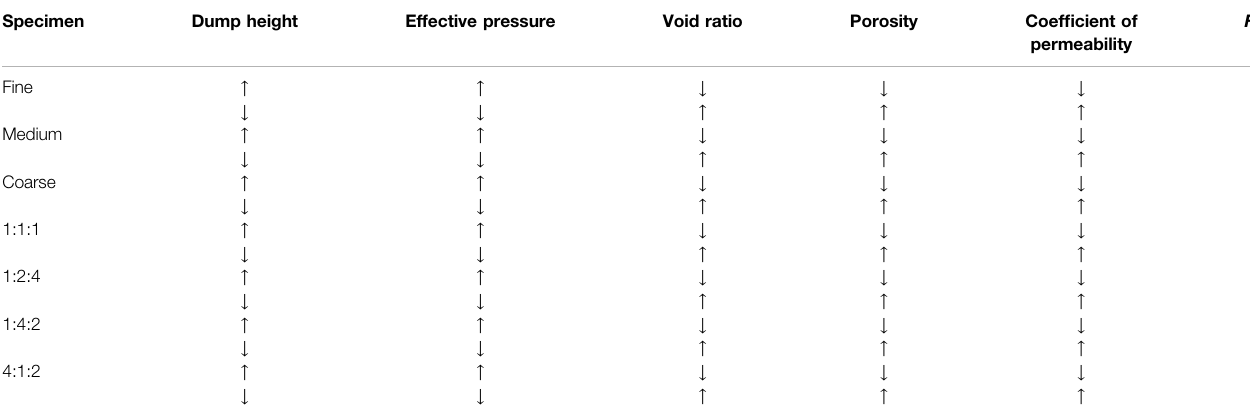
TABLE 3 | Relationship results of the experimental tests.